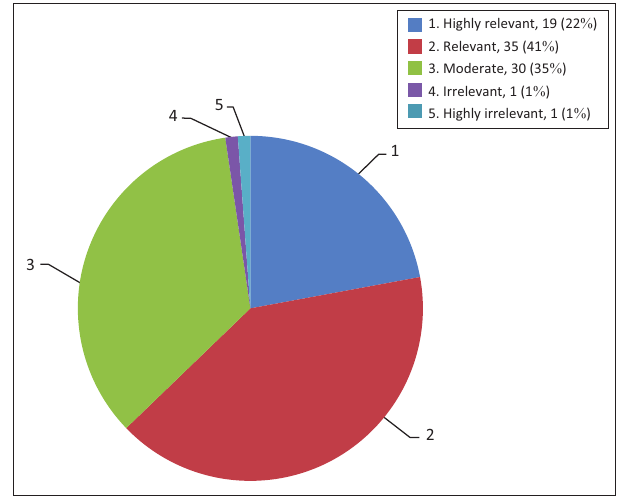
FIGURE 2: The relevance of social media.